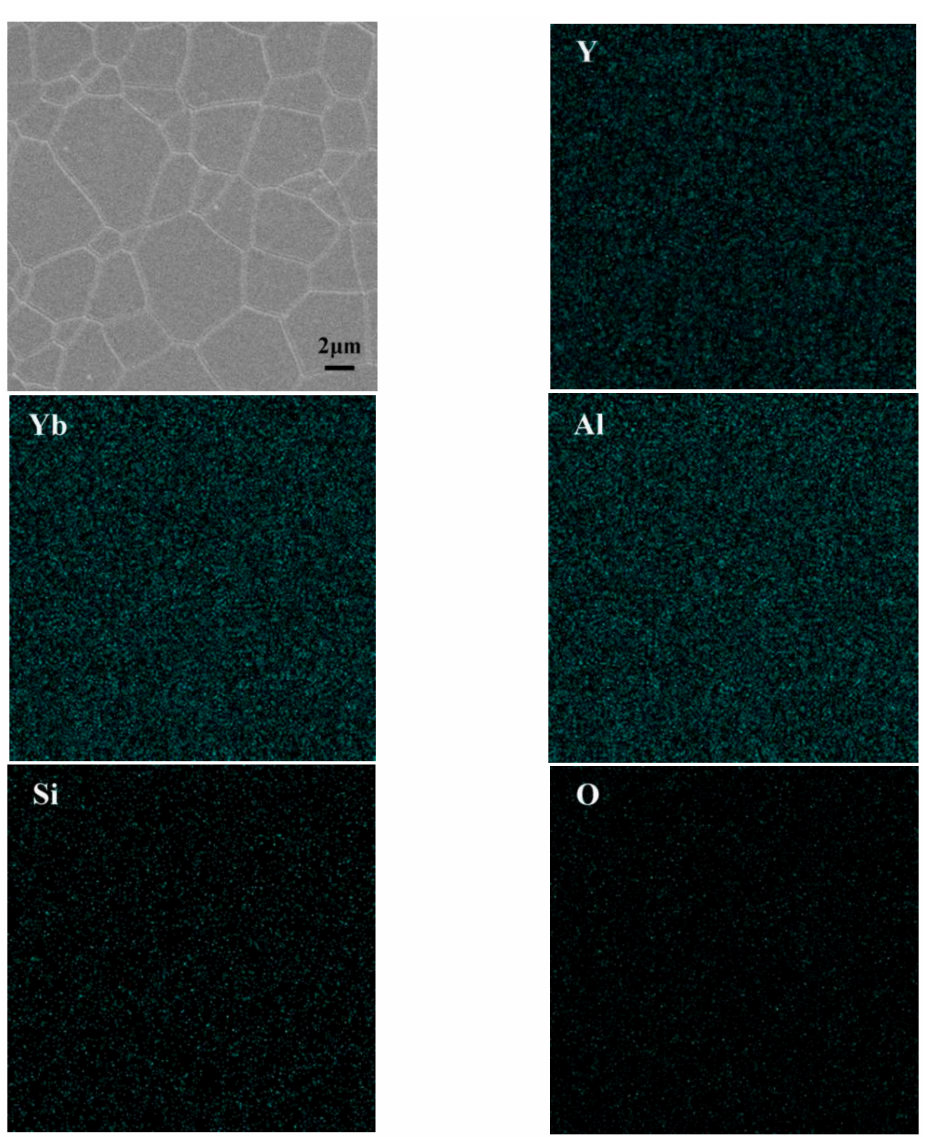
Figure 7. EDX spectra analysis of the composition distributions of the (Y 0.94 Yb 0.06 )AG transparent ceramic sintered at 1700 ◦